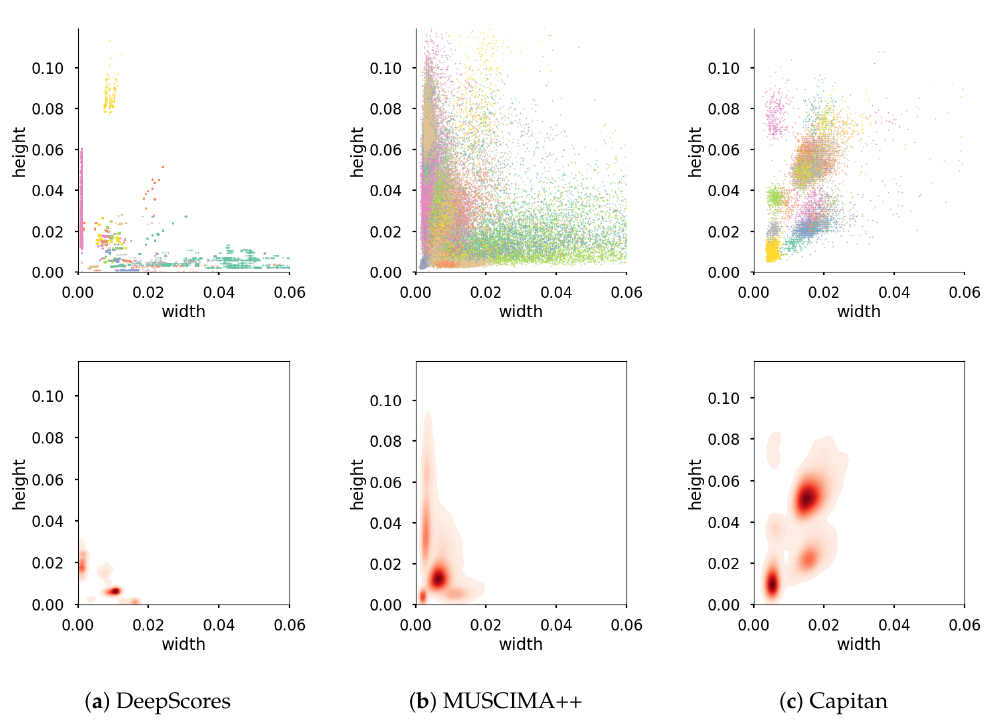
Figure 4. Scatter plot ( top ) row and density plot ( bottom ) row of the normalized object sizes for the considered corpora to illustrate the challenges of each dataset (best viewed in color). Each point in the top row depicts one instance from the dataset with the color encoding the respective class. The width and height of a sample are reported as the fraction of the full image